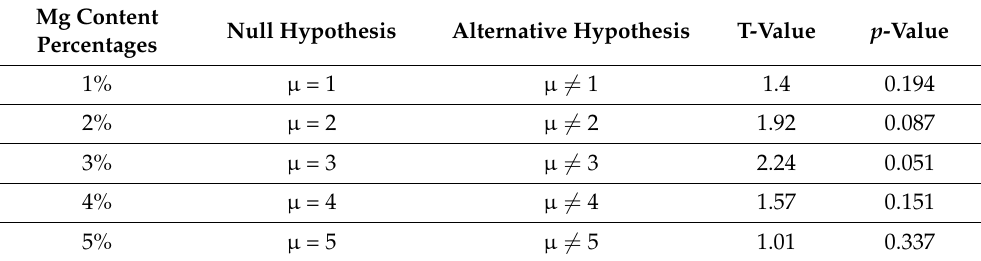
Table 3. The outcomes from one-sample t -test for Mg content percentiles.